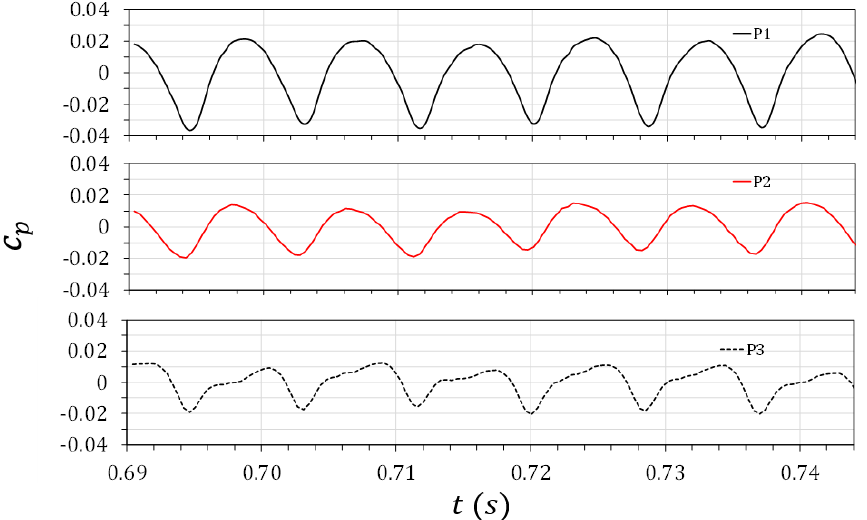
Figure 17. Time history plot of normalized pressure coefficient, 𝑐 𝑝 , on monitoring points P1, P2, and P3.